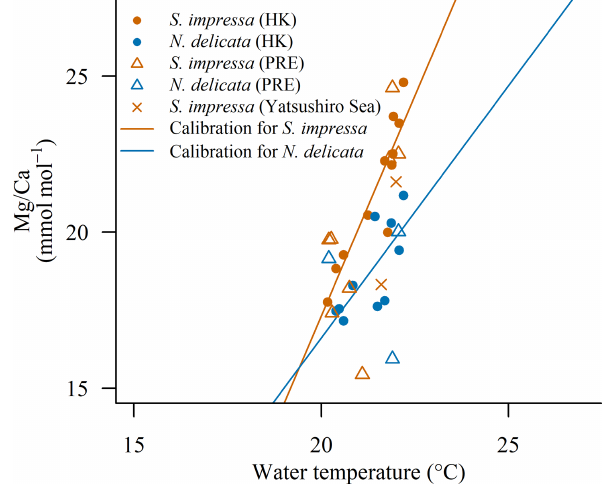
Figure 5. Mg / Ca ratios of ostracods from the PRE (OCEAN- HK) and Yatsushiro bay over the calibration for S. im- pressa (Mg / Ca S. impressa = 2 . 8 · T − 39 . 2) and N. delicata (Mg / Ca N. delicata = 1 . 6 · T − 15 . 7) performed with samples from Hong Kong (EPD). The BWT from the Copernicus product was used for OCEAN-HK samples. Surface water temperature from the Tanoura buoy in the last 15d in June (21.8 ◦ C) and November (21.9 ◦ C) were considered for the Yatsushiro Sea